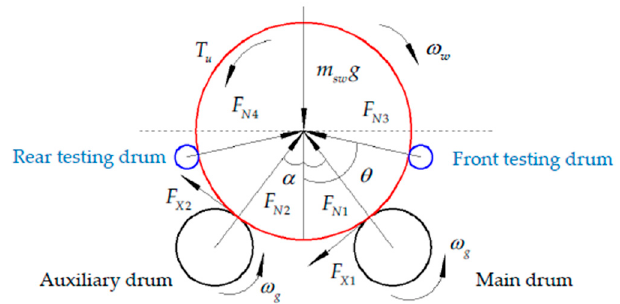
Figure 4. Analysis force of the single wheel.